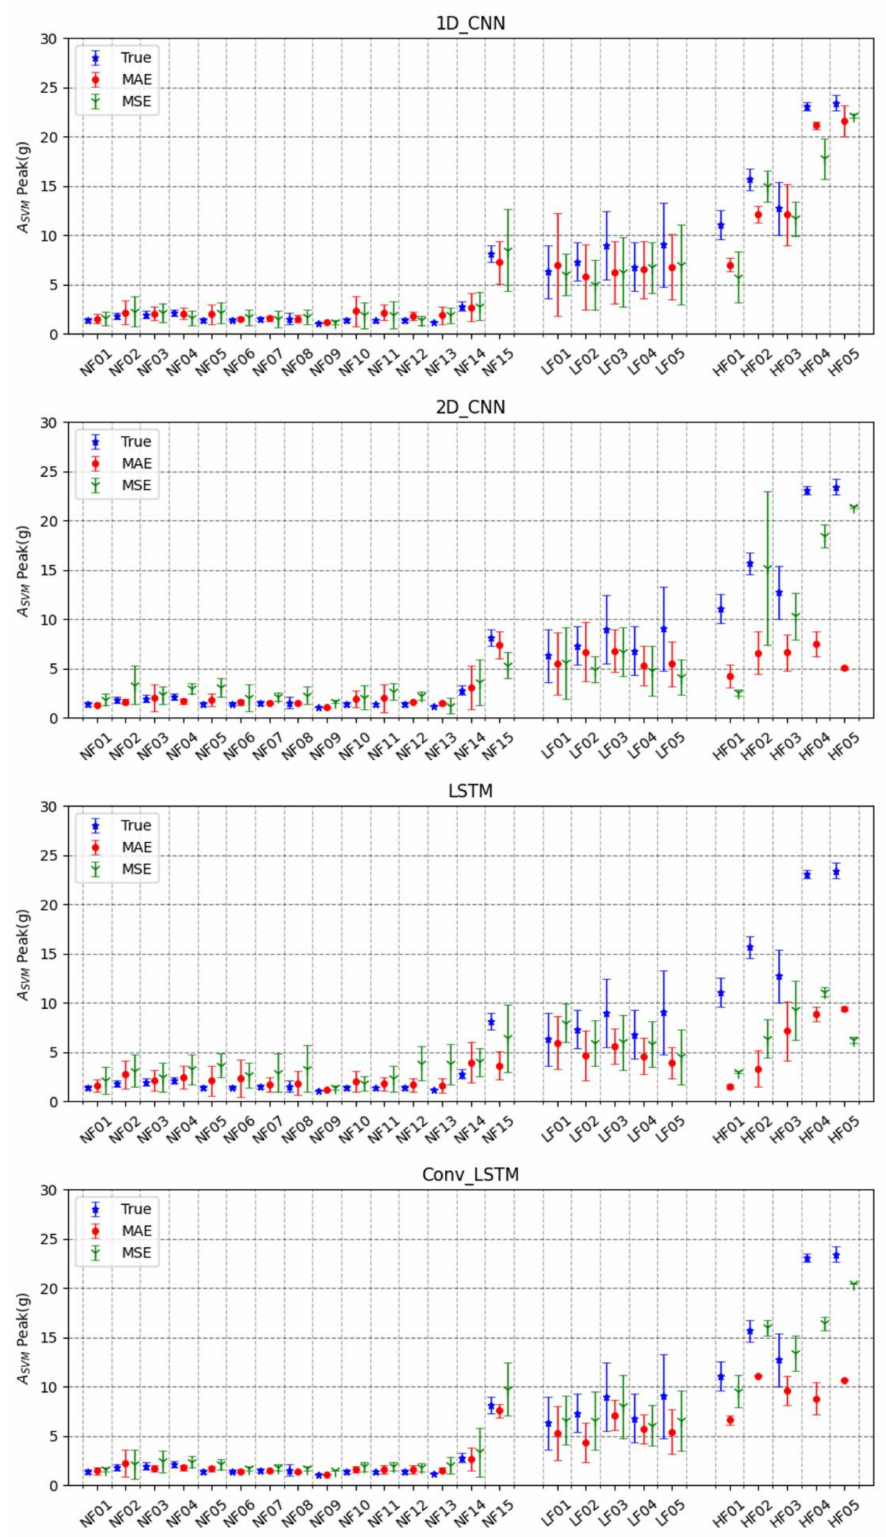
Figure 3. True vs. predicted (MSE, MAE) values of trained models for different